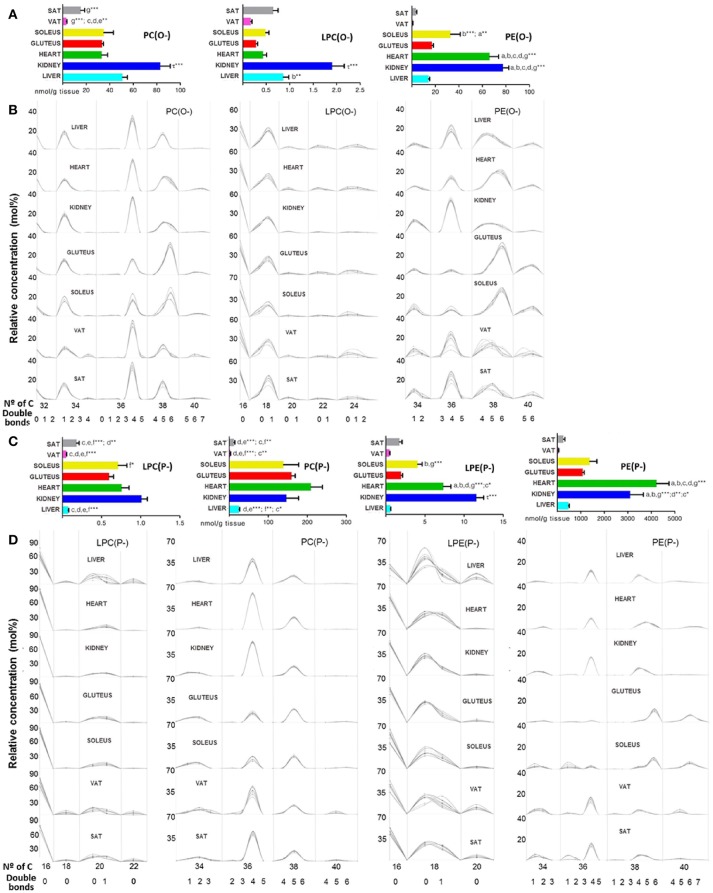
Ether lipid species within mammalian tissues detected by targeted lipidomic analysis. (A,C) Concentration of alkyl and alkenyl, respectively. Values are expressed as mean ± SEM from 8 to 10 animals. Statistical analysis was one-way anova and post-hoc Tukey significance is represented in the bar chart, meaning a significantly different respect to SAT, b respect to VAT, c respect to soleus, d respect to gluteus, e respect to heart and f respect to kidney, g respect to liver, τ respect to all. *p < 0.05, **p < 0.01, and ***p < 0.001. (B,D) Relative concentration of lipids normalized per sample to the total abundance within this lipid class to obtain molar fractions. Each solid line indicated tissue from an individual rat. Gray vertical lines separate lipids by total number of acyl chain carbons. The number of double bonds is indicated below within each group.